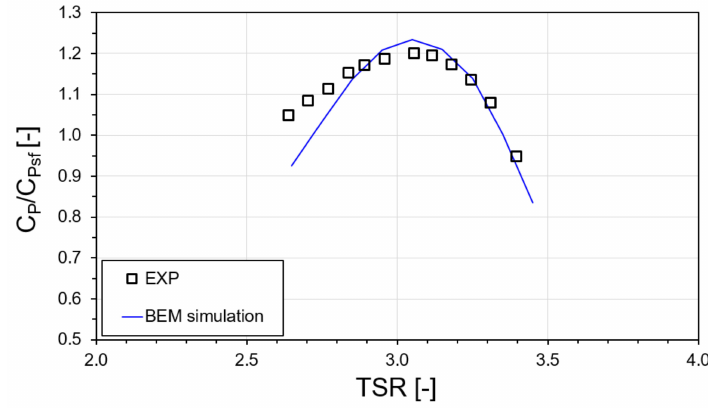
Figure 13. Comparison between the experimental turbine power curve (in dimensionless form) in turbulence and the predictions using the VARDAR code: the BEM code is run with the airfoil polars obtained for a 9.5% turbulence condition and at the equivalent wind speed of 9.2 m /